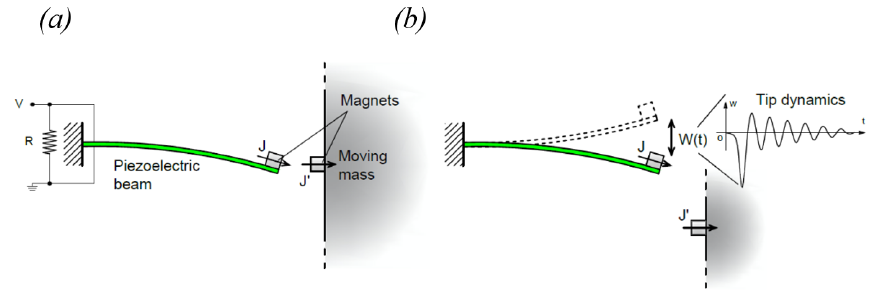
Figure 2. Illustration of the magnetic plucking mechanism: ( a ) the mass approaches the cantilever, ( b ) high frequency vibrations of the piezoelectric cantilever after the snap in case of attractive interaction.